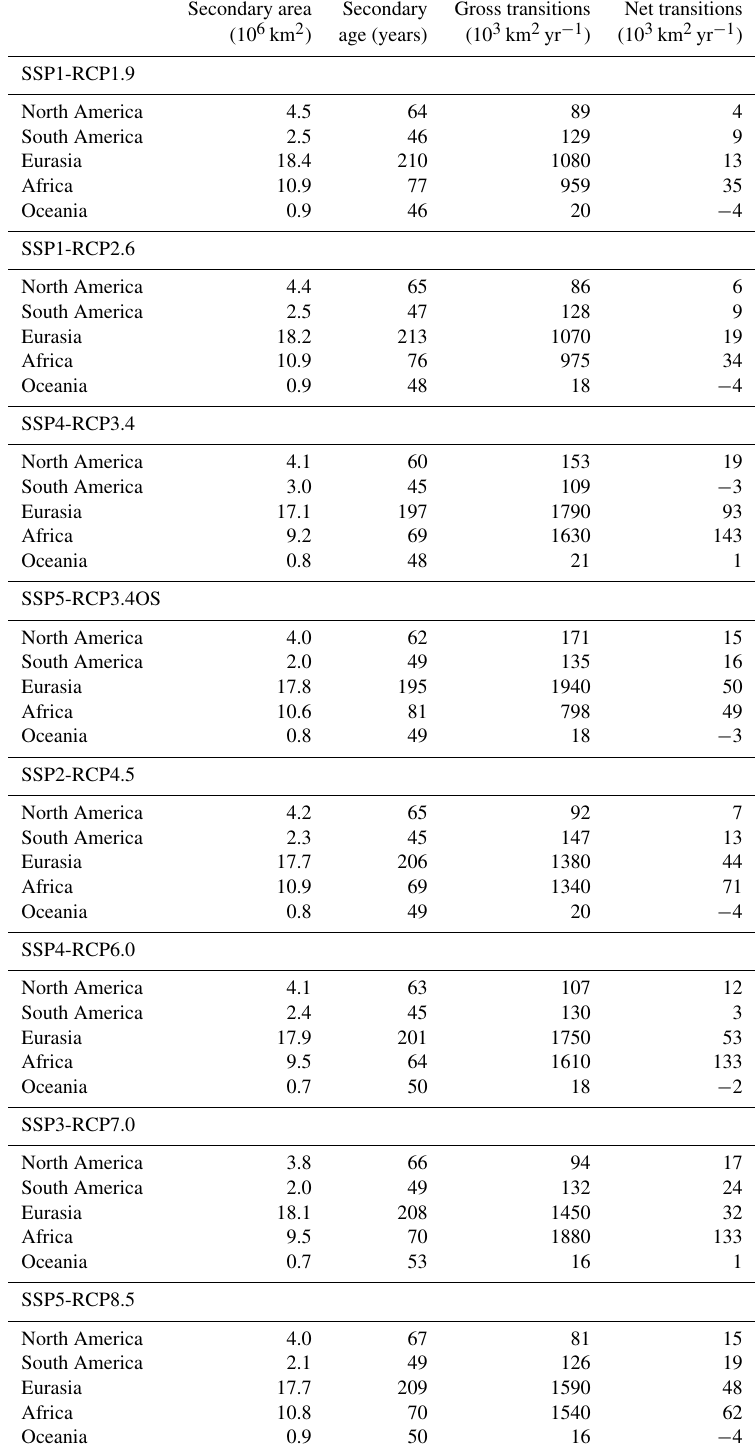
Table 7. Regional results averaged over the years